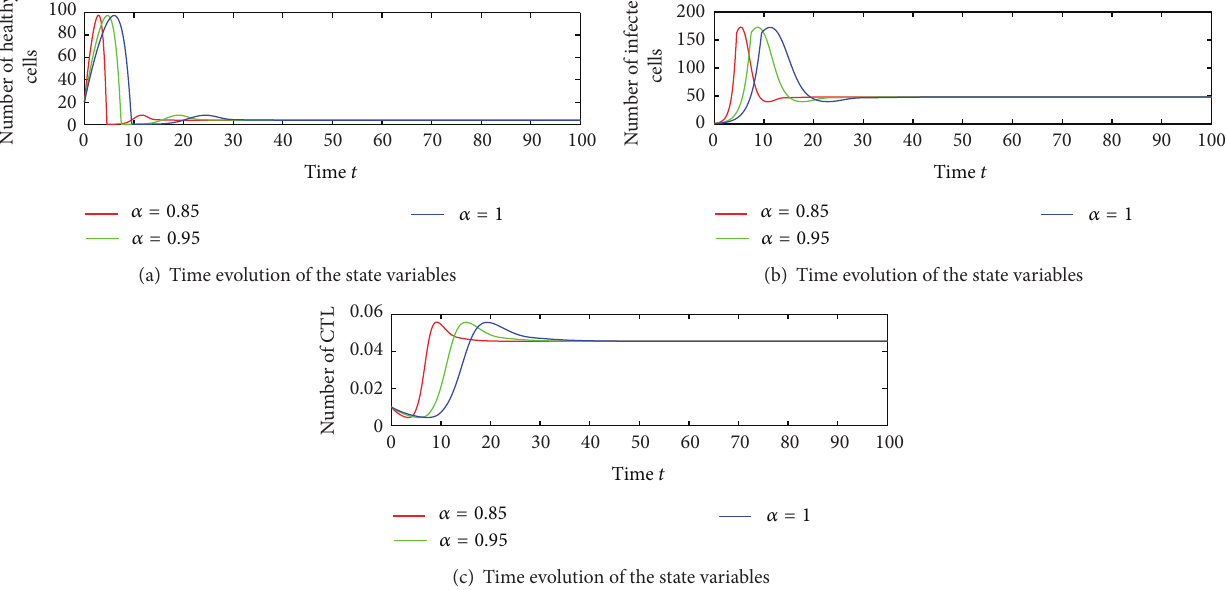
Figure 1: The diagrams show the time evolution of the trajectory of system (5) for healthy cells 𝑥(𝑡) , infected cells 𝑦(𝑡) , and the CTL 𝑧(𝑡) , respectively, with respect to 𝛼 = 0.85 , 𝛼 = 0.95 , and 𝛼 = 1 , in condition of 𝐷(𝑃) > 0 . The red lines correspond to 𝑥(𝑡) in (a), 𝑦(𝑡) in (b), and 𝑧(𝑡) in (c) for 𝛼 = 0.85 ; the green lines correspond to 𝑥(𝑡) in (a), 𝑦(𝑡) in (b), and 𝑧(𝑡) in (c) for 𝛼 = 0.95 and the blue lines for 𝛼 = 1 .